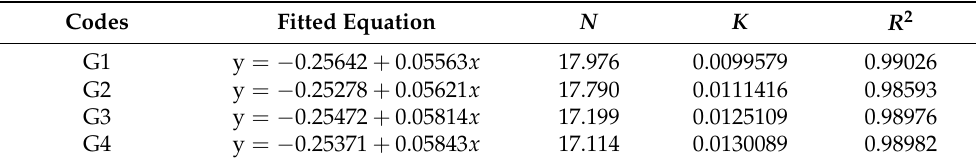
Table 6. Results of Kondo equation piecewise fitting hydration acceleration final stage.